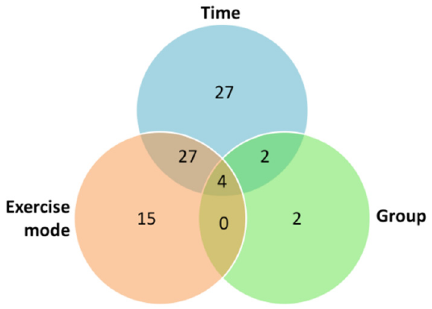
Figure 2. The results of three-way ANOVA in a Venn diagram. Numbers represent the sums of significant main effects and interactions with regards to all 46 serum metabolites determined by UPLC-MS/MS in serum (p < 0.05).